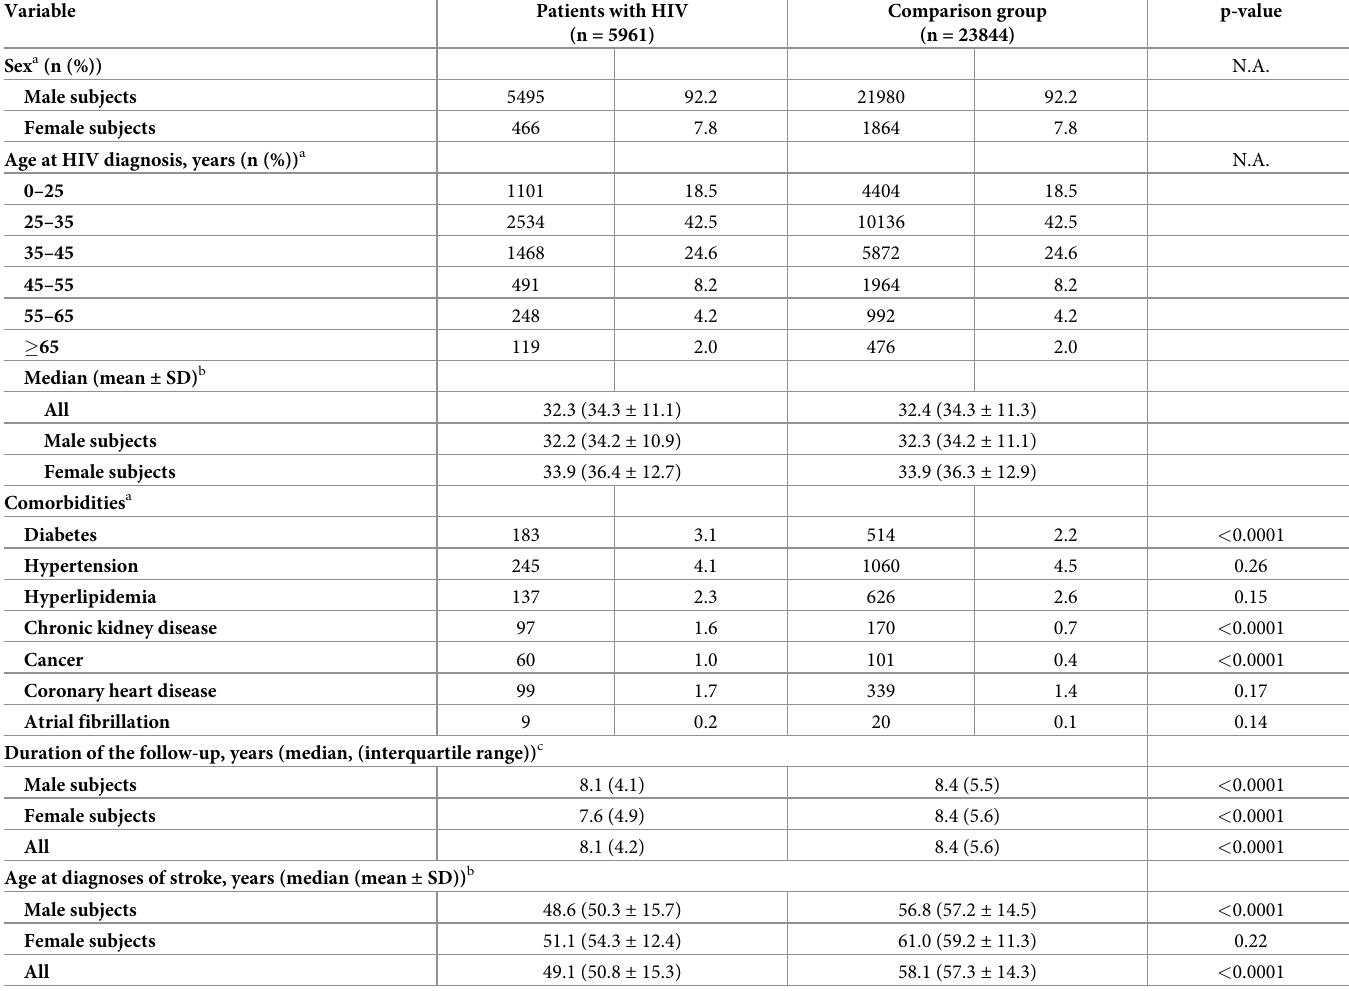
Table 1. Characteristics of patients with HIV infection and subjects in the comparison